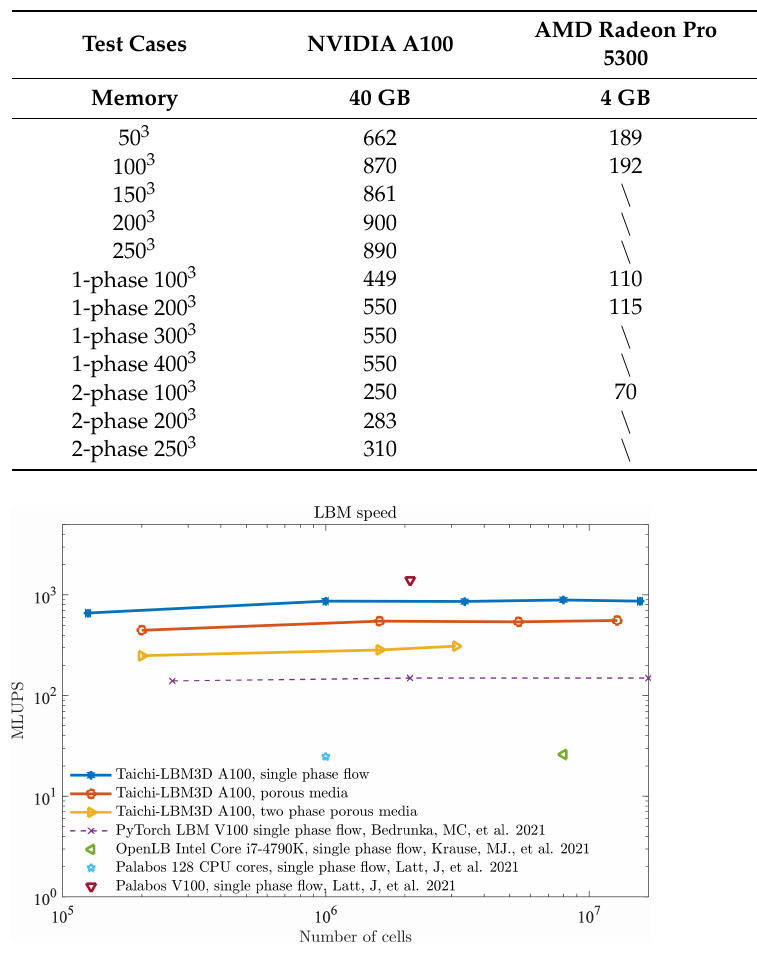
Figure 8. Performance of Taichi-LBM3D under different hardware with other codes measured in